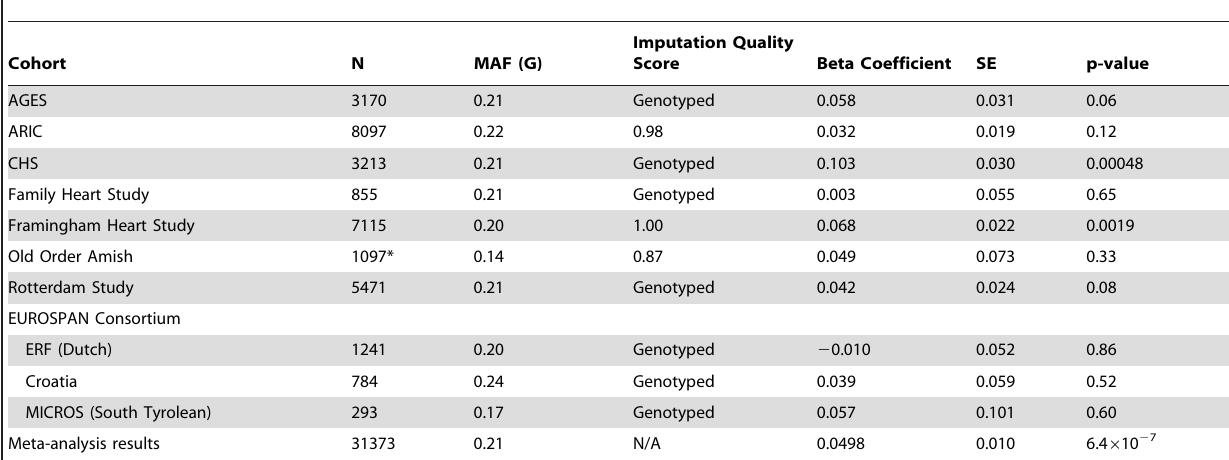
Figure 1. Regional Association Plot for rs10146997 on chromosome 14 in the stage 1 CHARGE-only analysis. The color scheme is red for strong linkage disequilibrium (LD; r 2 $ 0.8), orange for moderate LD (r 2 $ 0.5 and , 0.8), yellow for weak LD (r 2 $ 0.2 and , 0.5) and white for limited or no LD (r 2 , 0.2). doi:10.1371/journal.pgen.1000539.g001 Table 3. Results per copy of the G allele for rs10146997 by contributing study; beta coefficients expressed as